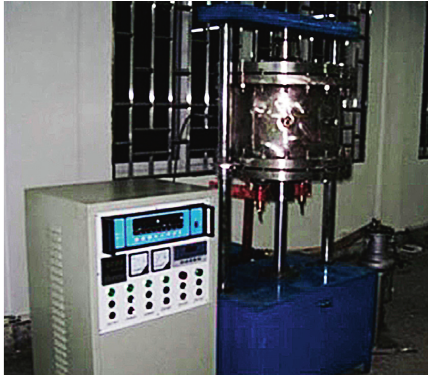
Figure 1: Hot-pressing sintering furnace. Table 1: Energetic material ratios and densities.